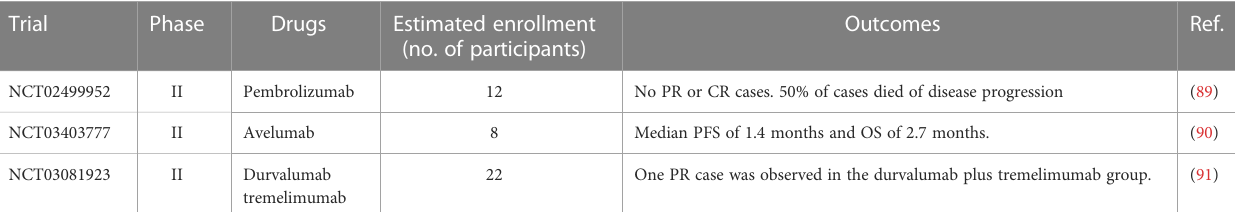
TABLE 2 Trials evaluating the effectiveness of immune checkpoint inhibitors in GCTs (89 –